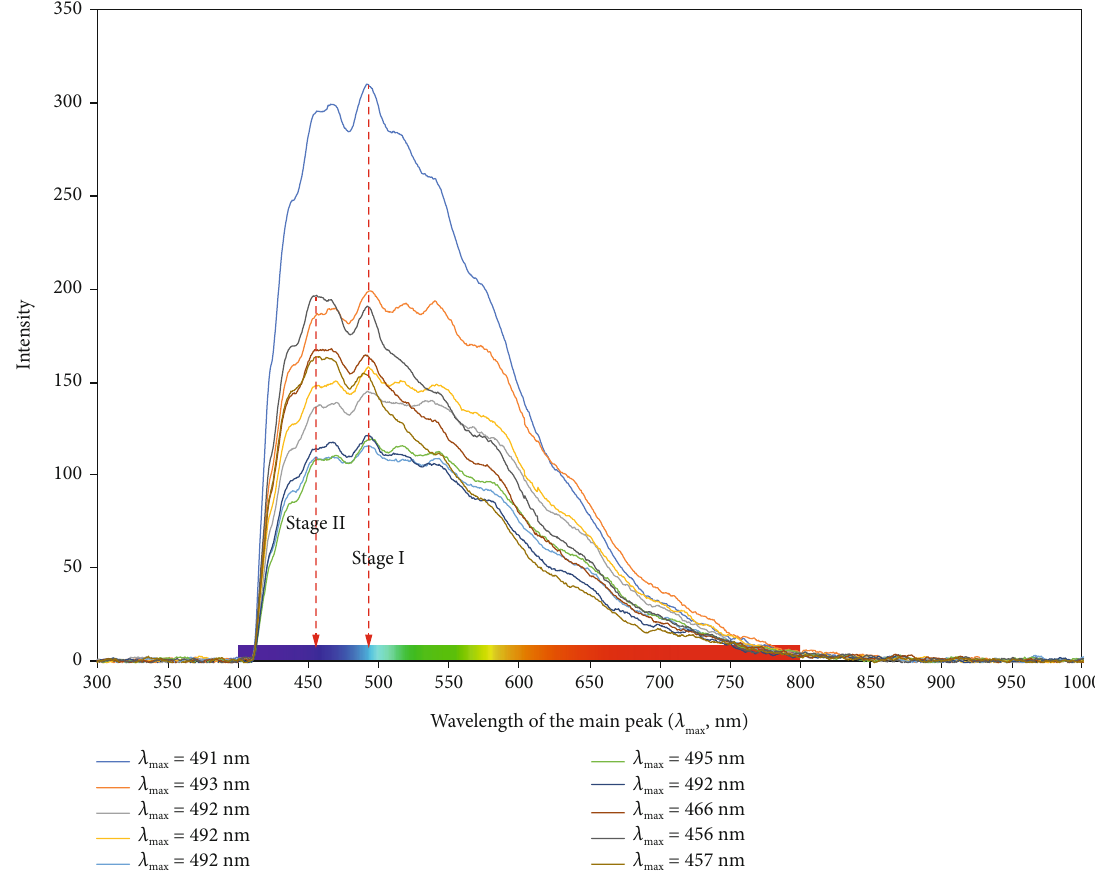
Figure 7: Longwangmiao Formation, Well MX20 (4605.34-4605.59 m). Graphical representation of the microbeam fl uorescence spectrum of individual oil